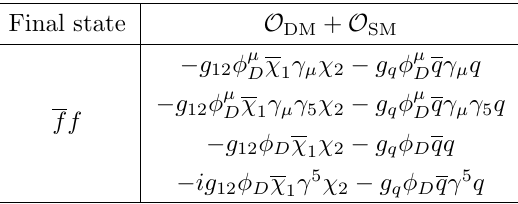
Table 3 . A small sample list of example vector, axial-vector, scalar, and pseudo-scalar decay mediator couplings for fermionic DM particles. Similar models may also be constructed for bosons.